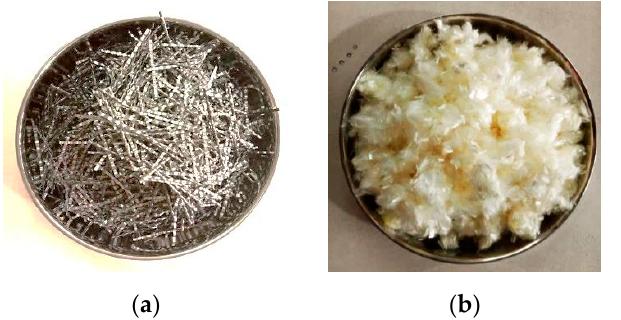
Figure 4. Metallic and non-metallic fibre: ( a ) crimped steel fibre (CR) (60 mm); ( b ) polyvinyl alcohol fibre (PVA) (12 mm). Table 1. Properties of Used Material. Table 2. Chemical analysis of C WC and cement (OPC 43).